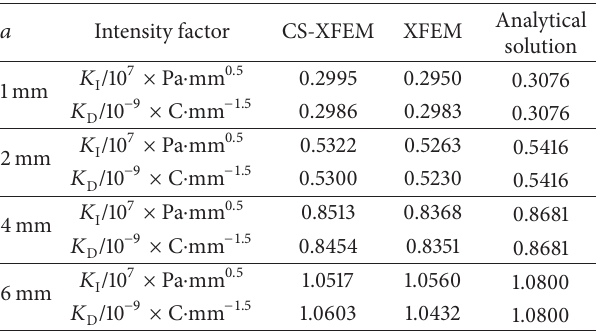
Table 6: Intensity factor under different crack